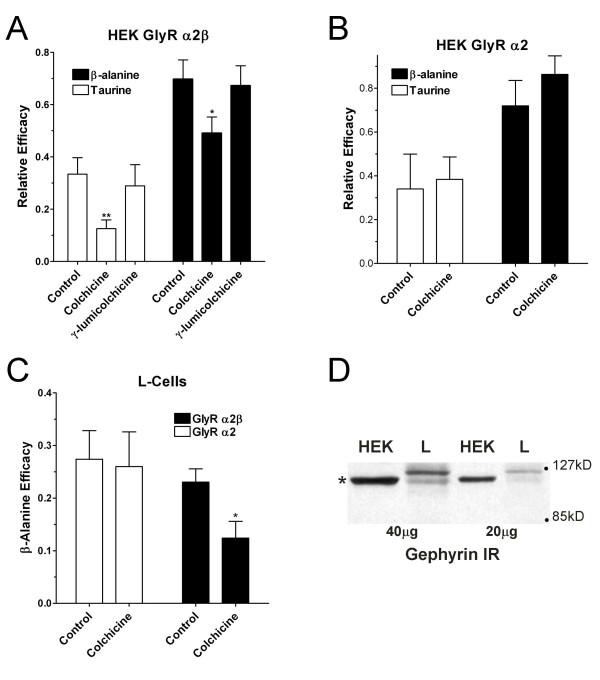
The association of glycine receptors with the tubulin-cytoskeleton may influence partial agonist efficacy. (A) Tubulin depolymerization with colchicine decreased both taurine and β-alanine efficacy of α2β glycine receptors expressed in HEK 293 cells. Cells were treated with 100 μM colchicine or γ-lumicolchicine at 37°C for 30 minutes. The graph shows the partial agonist efficacy as a fraction of the maximal glycine response. For taurine (□), colchicine treatment reduced apparent efficacy from 33 ± 6% in control cells (n = 8) to 13 ± 3% in treated cells (n = 10). γ-lumicolchicine, an inactive analogue of colchicine, had no effect on taurine efficacy (29 ± 9%, n = 5, ** – P < 0.01 from ANOVA). For β-alanine (■), efficacy was reduced from 70 ± 7% in vehicle-treated cells (n = 8) or 67 ± 8% in γ-lumicolchicine-treated cells (n = 5) to 49 ± 6% in cholchicine-treated cells (n = 10, * – P < 0.05, ANOVA). (B) Colchicine treatment does not influence partial agonist efficacy of the GlyRα2 homomeric channels. Taurine (□) efficacy was 34 ± 15% in control GlyRα2 cells (n = 4) and was 38 ± 10% in colchicine-treated cells (n = 5, P >> 0.05 t-test). Similarly, β-alanine efficacy was 72 ± 12% and 86 ± 8% in the same control and treated cells, respectively (P >> 0.05, t-test). (C) Colchicine treatment decreases β-alanine efficacy in L-cells expressing GlyRα2β heteromeric channels (■), but not those expressing GlyRα2 homomeric channels (□). For the GlyRα2β channels, colchicine treatment significantly reduced efficacy from 23 ± 2% (n = 7) to 12 ± 3% (n = 3, P < 0.05 t-test). (D) Gephyrin-like immunoreactivity was detected in both cells lines using 20 and 40 μg of whole cell lysate. * – denotes expected gephyrin mobility (approx. 100 kD).